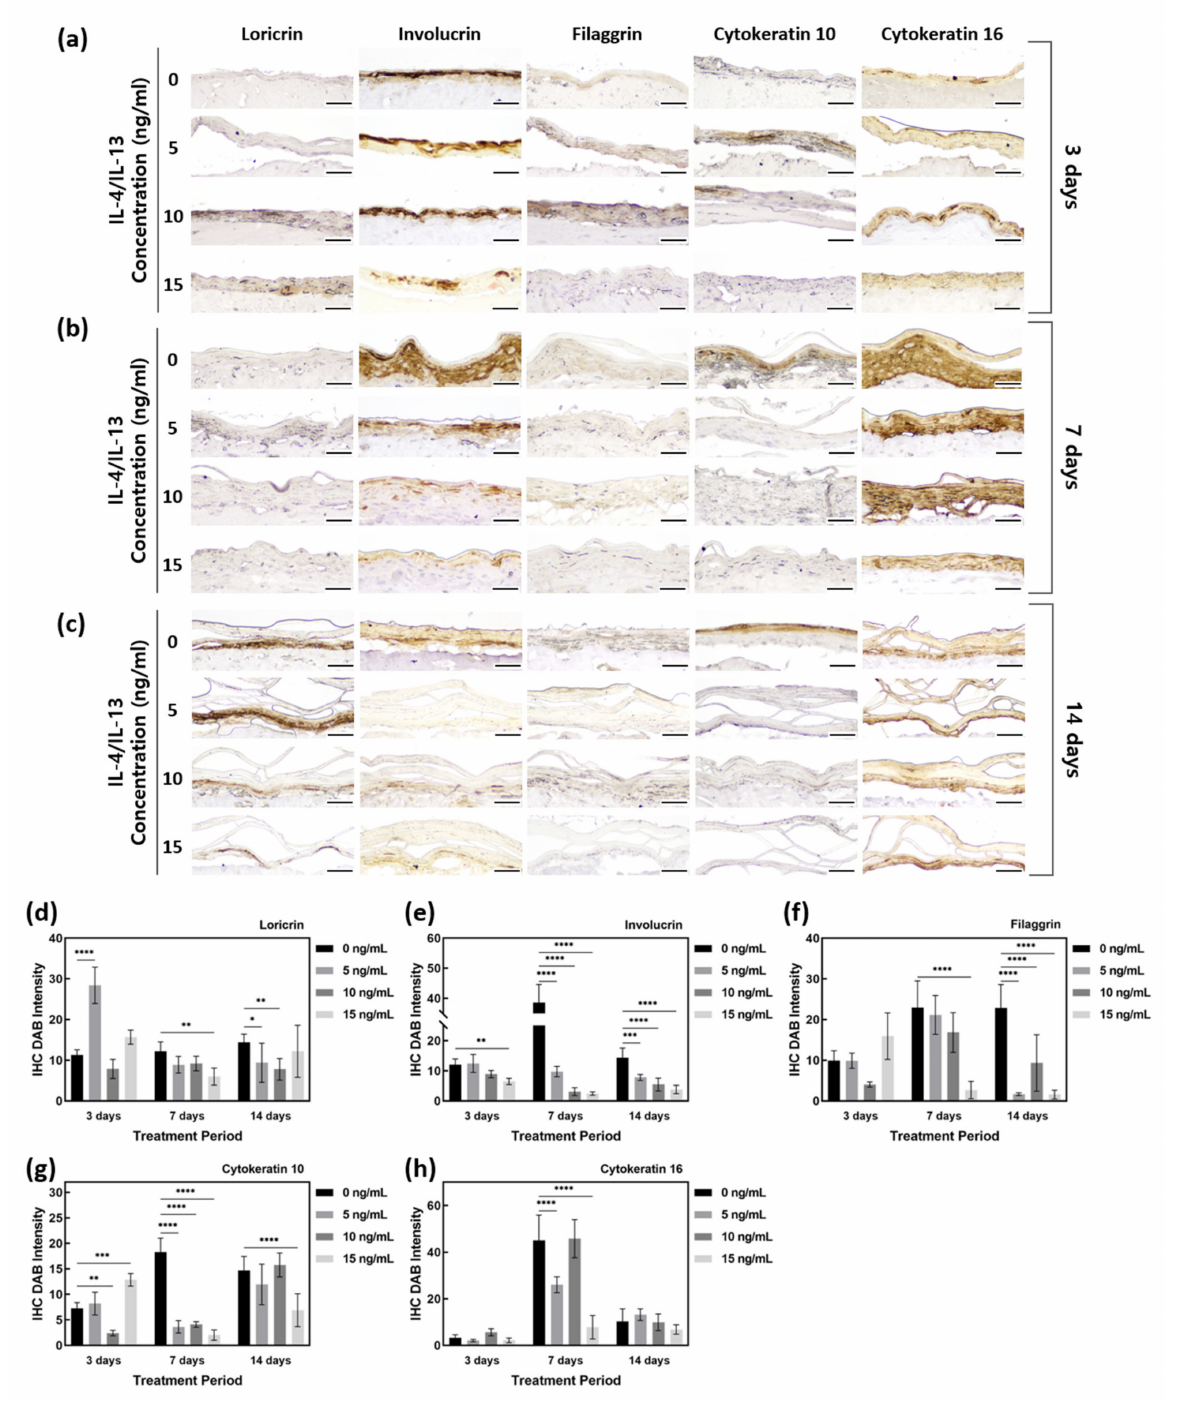
Figure 3. Quantification of IHC staining of AD-HSE stimulated with IL-4/IL-13. ( a ) IHC-stained images of epidermis-forming proteins of AD-HSE stimulated with IL-4/IL-13 for 3 days. ( b ) IHC- stained images of epidermis-forming proteins of AD-HSE stimulated with IL-4/IL-13 for 7 days. ( c ) IHC-stained images of epidermis-forming proteins of AD-HSE stimulated with IL-4/IL-13 for 14 days. (The scale bar sizes of a, b and c are 50 µ m.) ( d – h ) Epidermis-forming proteins loricrin, involucrin, filaggrin, cytokeratin 10 and cytokeratin 16 ( n = 5; *, p < 0.05; **, p < 0.01; ***, p < 0.001; ****, p <